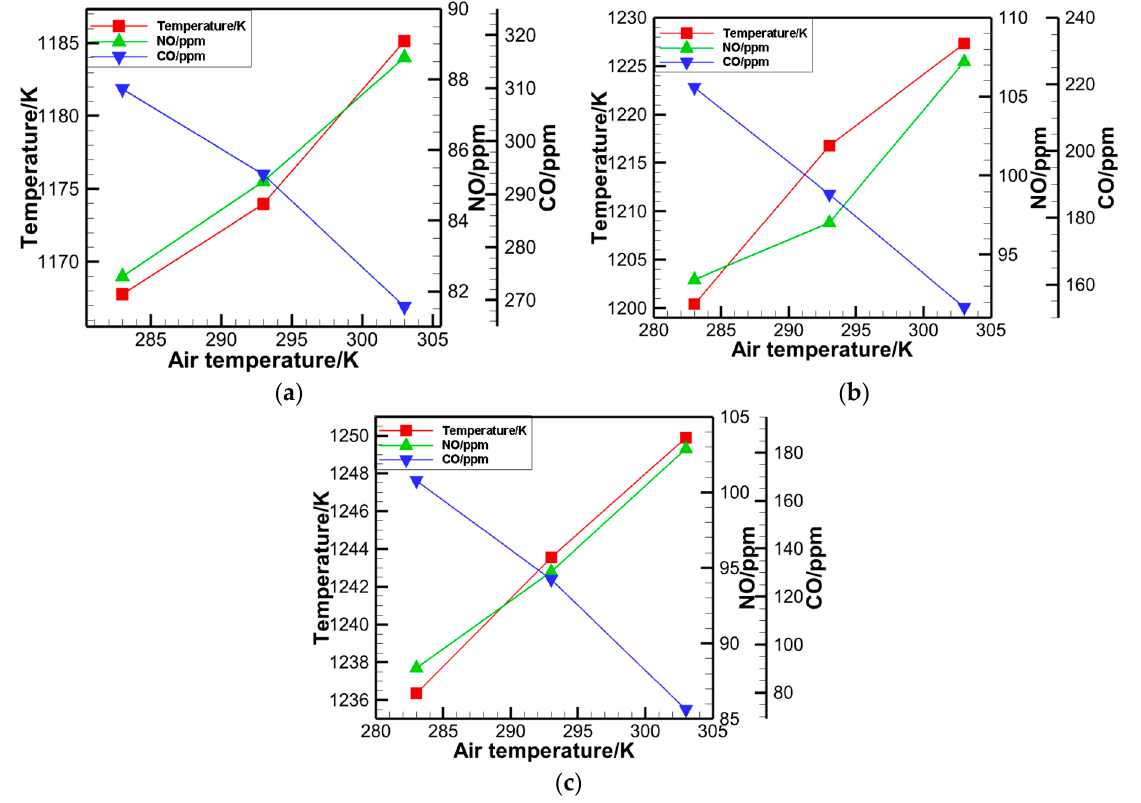
Figure 13. Effects of atmospheric temperature variations on startup emissions. ( a ) Diffusion; ( b ) Sub- pilot premix; ( c ) Pilot